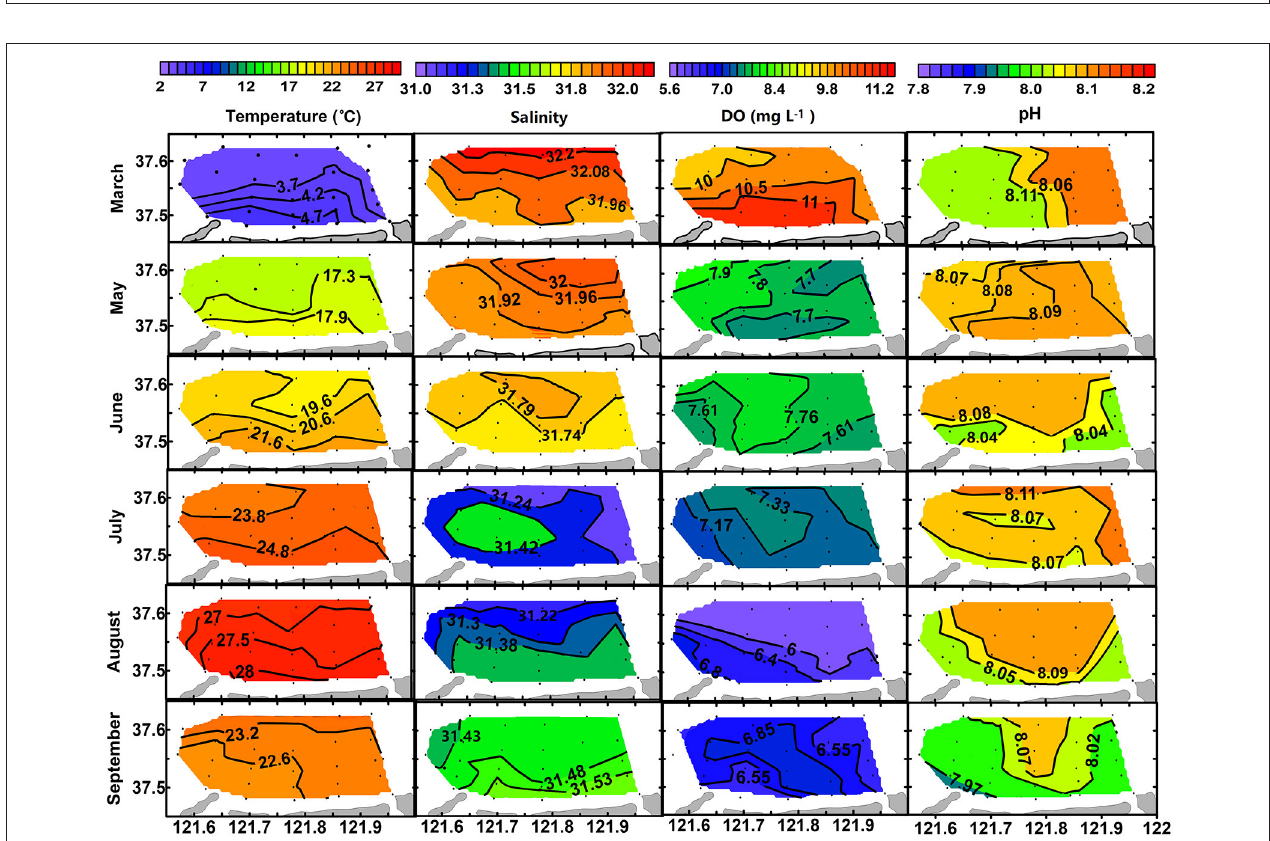
FIGURE 3 | Surface distribution of temperature ( ◦ C), salinity, DO (mg L − 1 ), and pH from March to September of 2016.